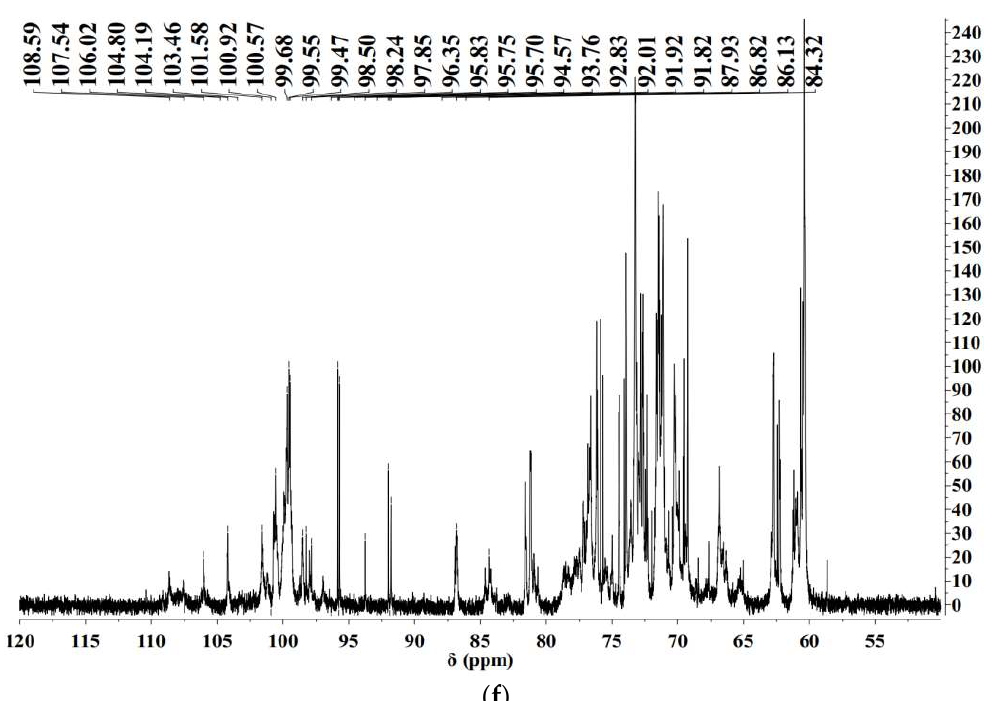
Figure 1. Structural characterizations of polysaccharides. ( A ) Elution curves of crude polysaccharide fractions from SPP, BSP, and PPP on a DEAE Cellulose–52 column. ( B ) Ion chromatograms of sixteen standard monosaccharides and monosaccharide compositions of SPP, BSP, and PPP. ( C ) FT–IR spectra of SPP, BSP and PPP. ( D ) Nuclear Magnetic Resonance (NMR) Spectra. 1 H NMR ( a – c ) and 13 C NMR ( d – f ) spectra of BSP, SPP, and PPP.